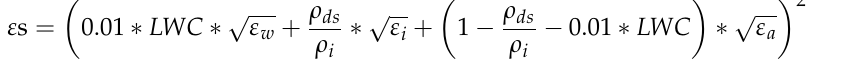
Figure 4. Processed radargram from the midday North Transect survey on 19 June 2019. The bright white reflector, that varies from 4 to 7 ns depth was identified as the snow–ground interface, as the reflector’s brightness indicates a large shift in permittivity. We picked this continuous reflector, as is noted by the red line. Depth was calculated using a radar velocity of 0.14 m ns −1 .